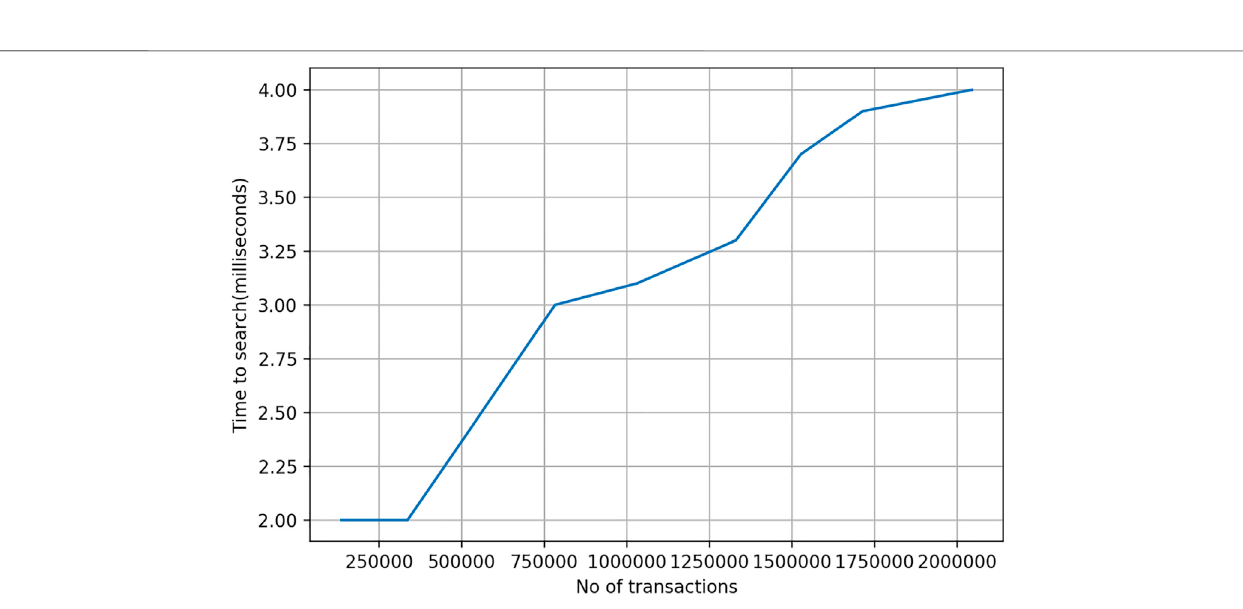
Frontiers in Blockchain |